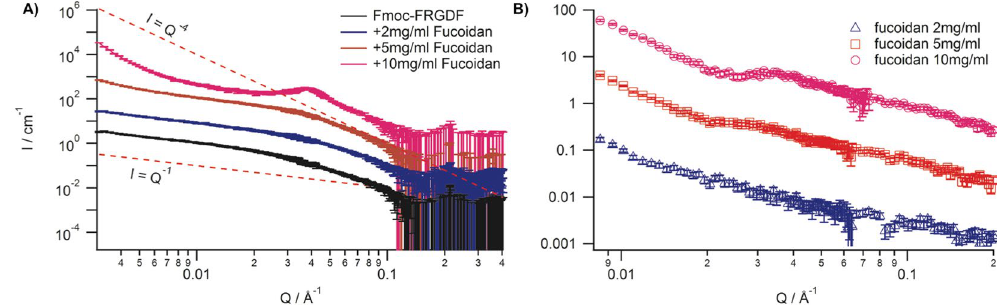
Figure 3. ( A ) SANS from hydrogels formed with fucoidan under conditions of fucoidan contrast matching, where increases in low Q scattering with higher fucoidan concentration result from an increased density of large objects in the sample. ( B ) SANS from pure fucoidan solution in D 2 O shows polyelectrolyte scattering with a single broad peak Q *